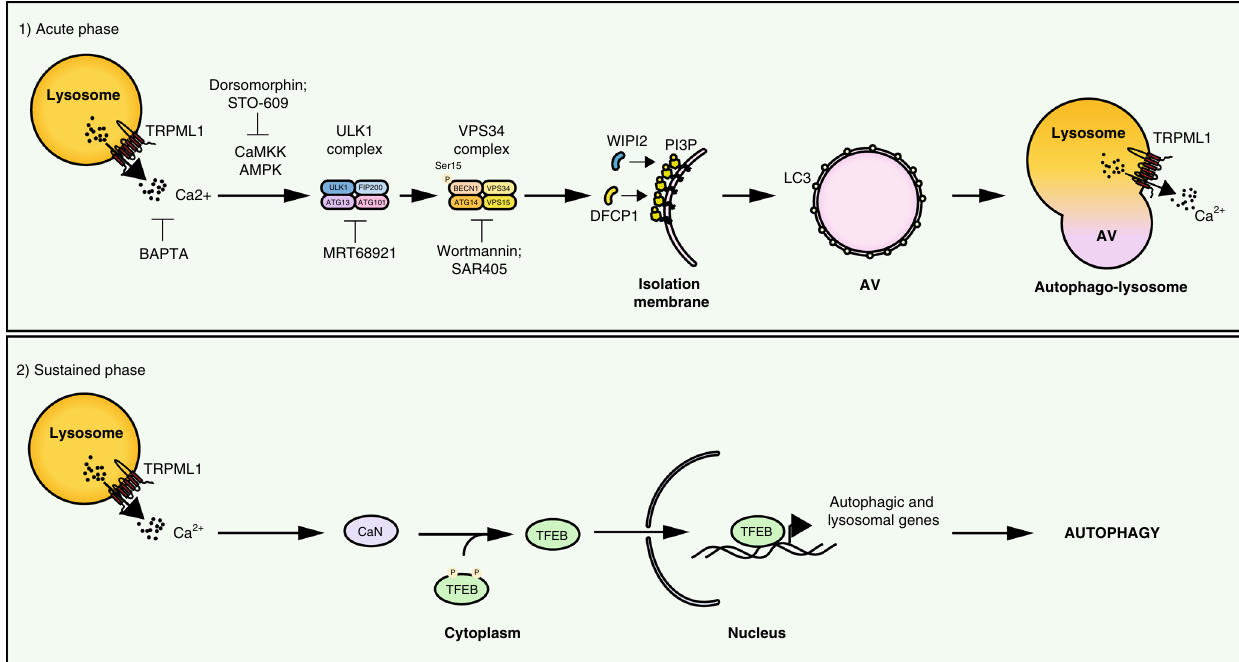
Fig. 7 Model of TRPML1 regulation of autophagy. Model of multistep regulation of autophagy by TRPML1. TRPML1 modulates autophagy in two steps: (1) by rapidly inducing AV biogenesis and AV – lysosomal fusion through the activation of the calcium/calmodulin-dependent protein kinase kinase (CaMKK β )- mediated signaling and the two major protein complexes involved in autophagy initiation, ULK1 and hVPS34, and (2) by inducing TFEB nuclear translocation that promotes the transcription of autophagic and lysosomal genes, which is necessary for a sustained induction of